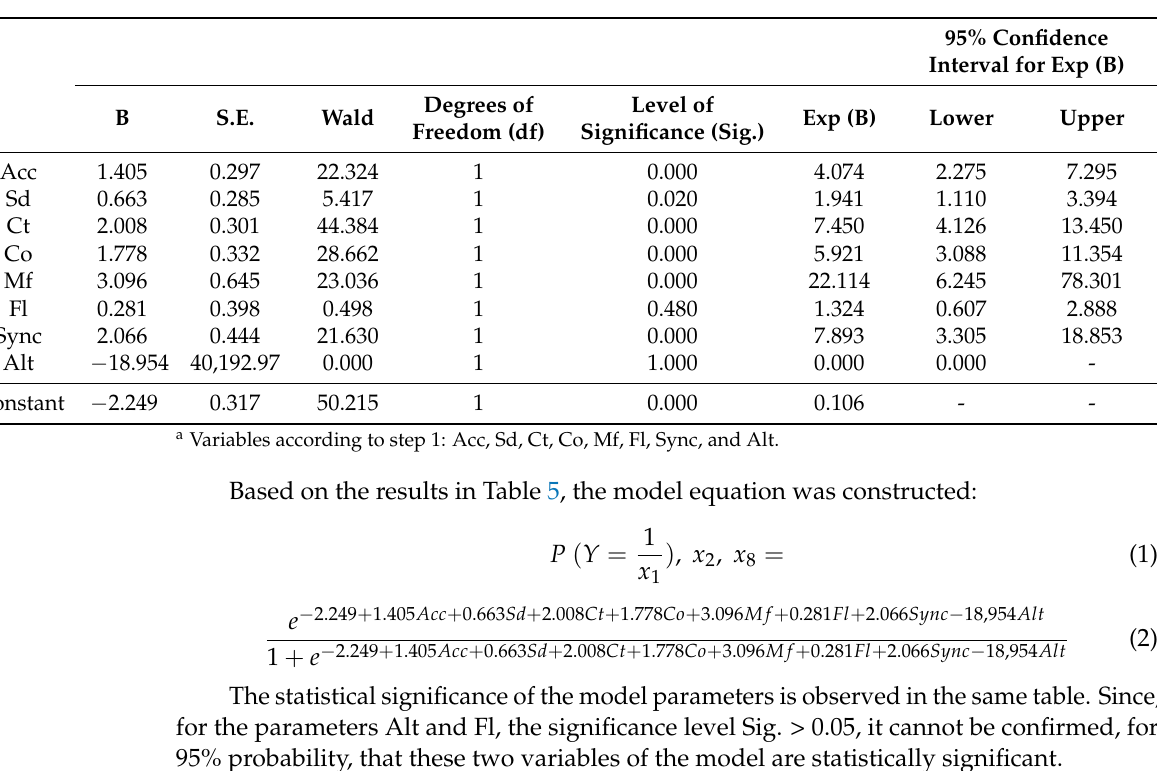
Table 5. Variables included in the model